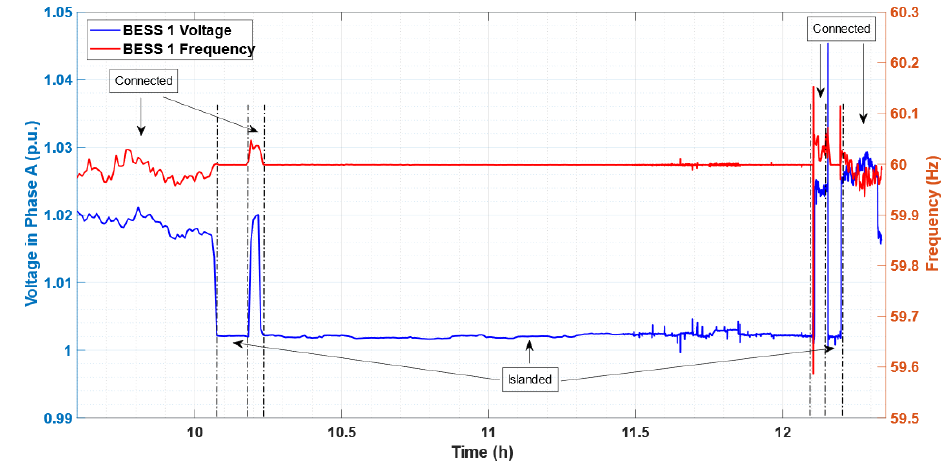
Figure 9. Voltage and frequency of BESS 1 were collected in the power